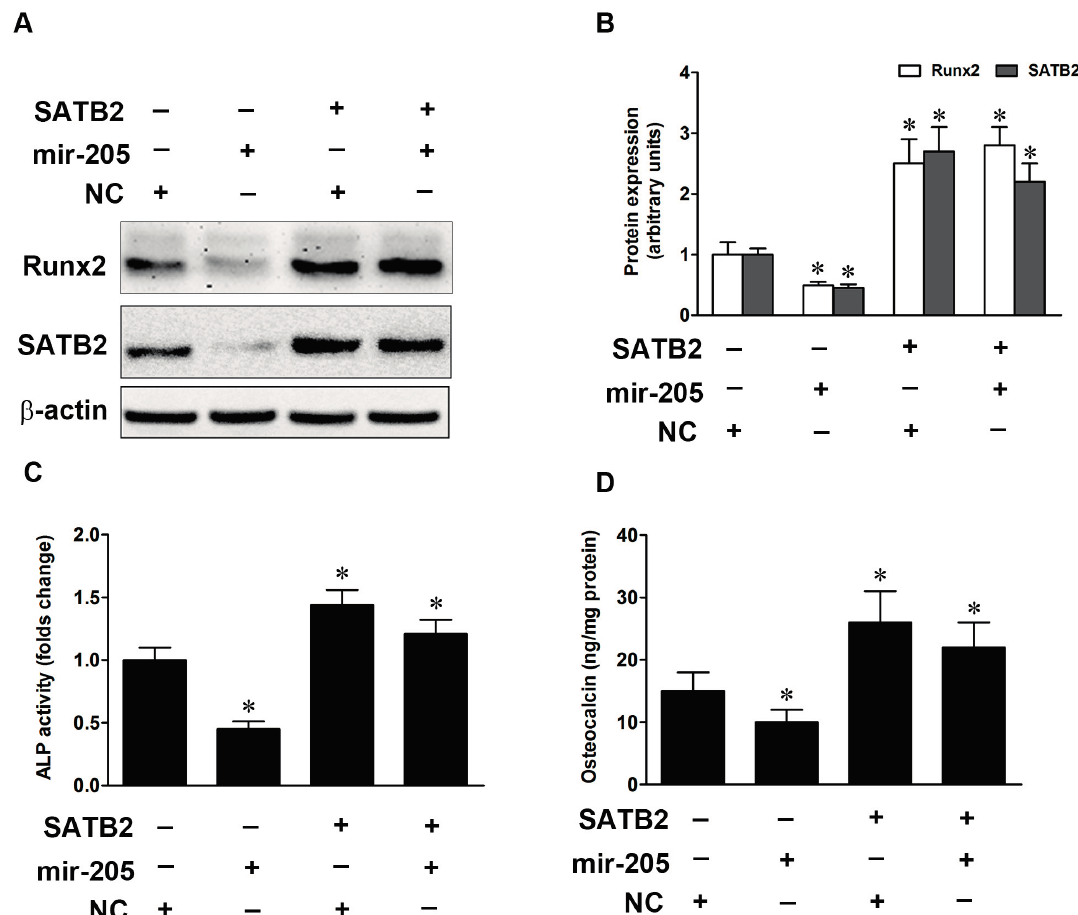
Figure 4. SATB2 activates Runx2 expression and regulates mir-205-mediated osteogenic differentiation. ( A , B ) SATB2 and Runx2 protein expression after transfected with SATB2 over-expression plasmid in mir-205 over-expression BMSCs; ( C ) ALP activity was determined by ALP assay and expressed relative to total cellular protein; ( D ) Osteocalcin levels were measured by ELISA and expressed relative to total cellular protein. Data are depicted as mean ± SD, * p < 0.05 vs.